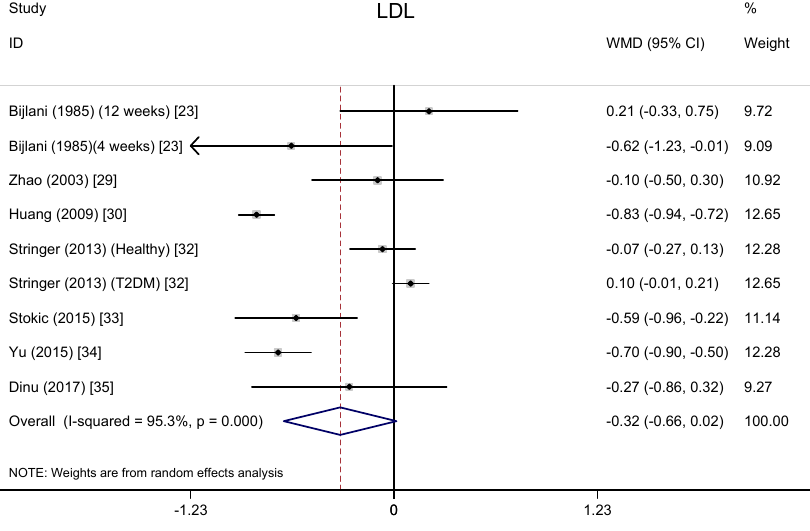
Figure 4. Meta-analysis of the effects of buckwheat products intake on blood LDL cholesterol concentration compared with baseline or control groups for human studies. Sizes of data markers indicate the weight of each study in the analysis. WMD, weighted mean difference (the results were gained from a random-effects model). Negative values favor a reduction in blood LDL cholesterol with buckwheat consumption; the dashed line shows the overall WMD value and the size of the rhombus the cumulative effect size and CI.